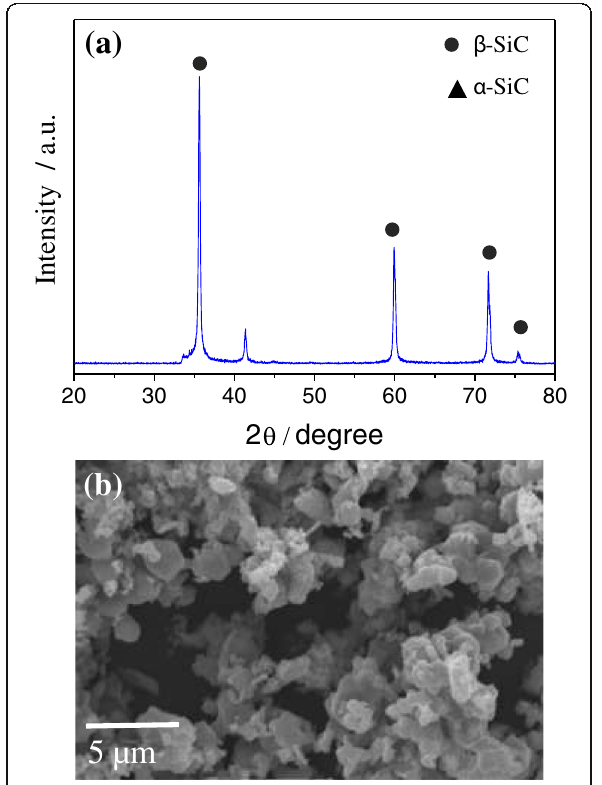
Fig. 2 XRD profile ( a ) and FESEM image ( b ) of micron-sized SiC synthesized by solid-state method